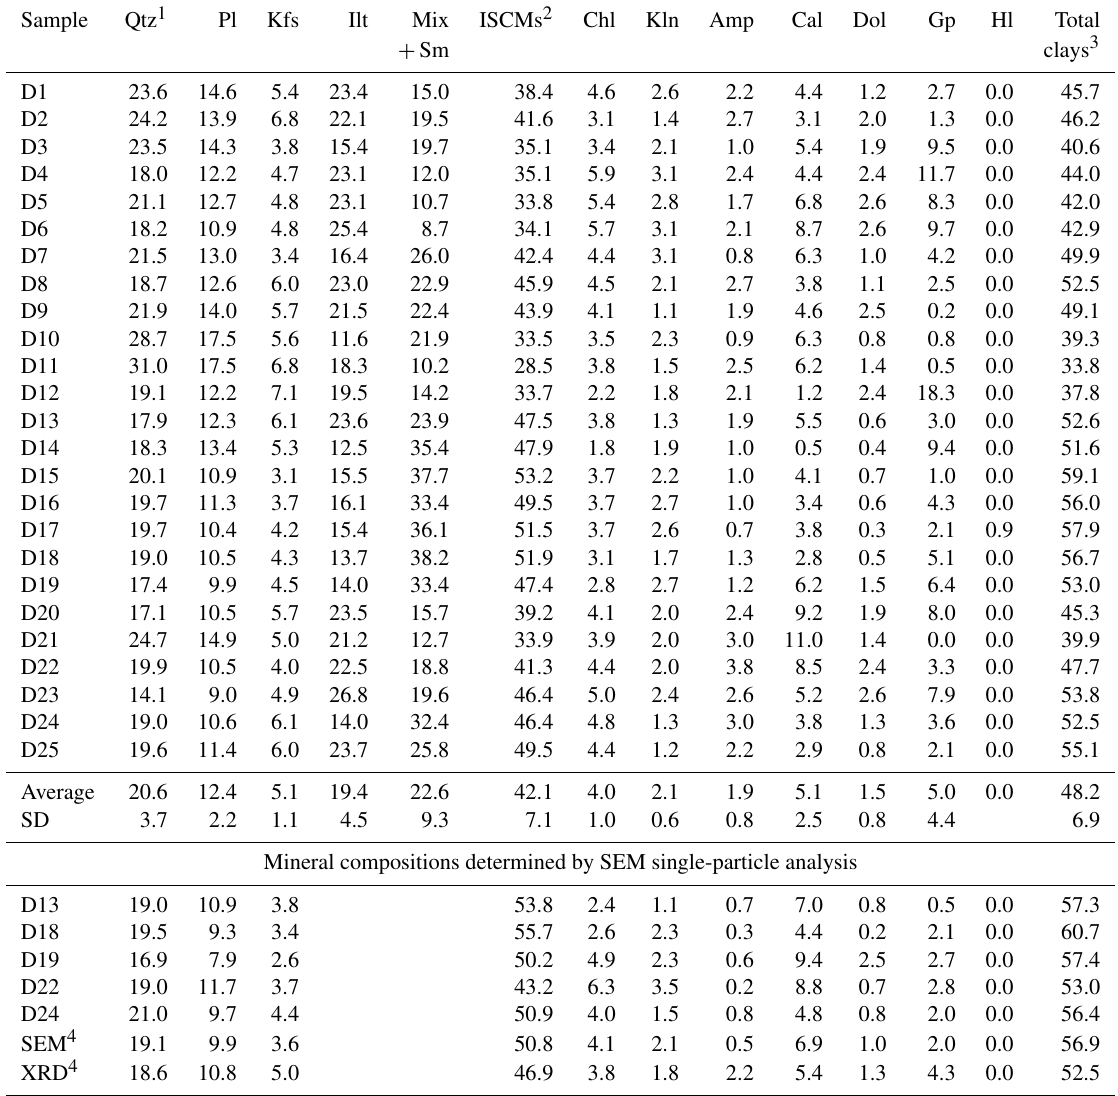
Table 2. Mineral compositions of Asian dust (wt%) determined by X-ray diffraction.